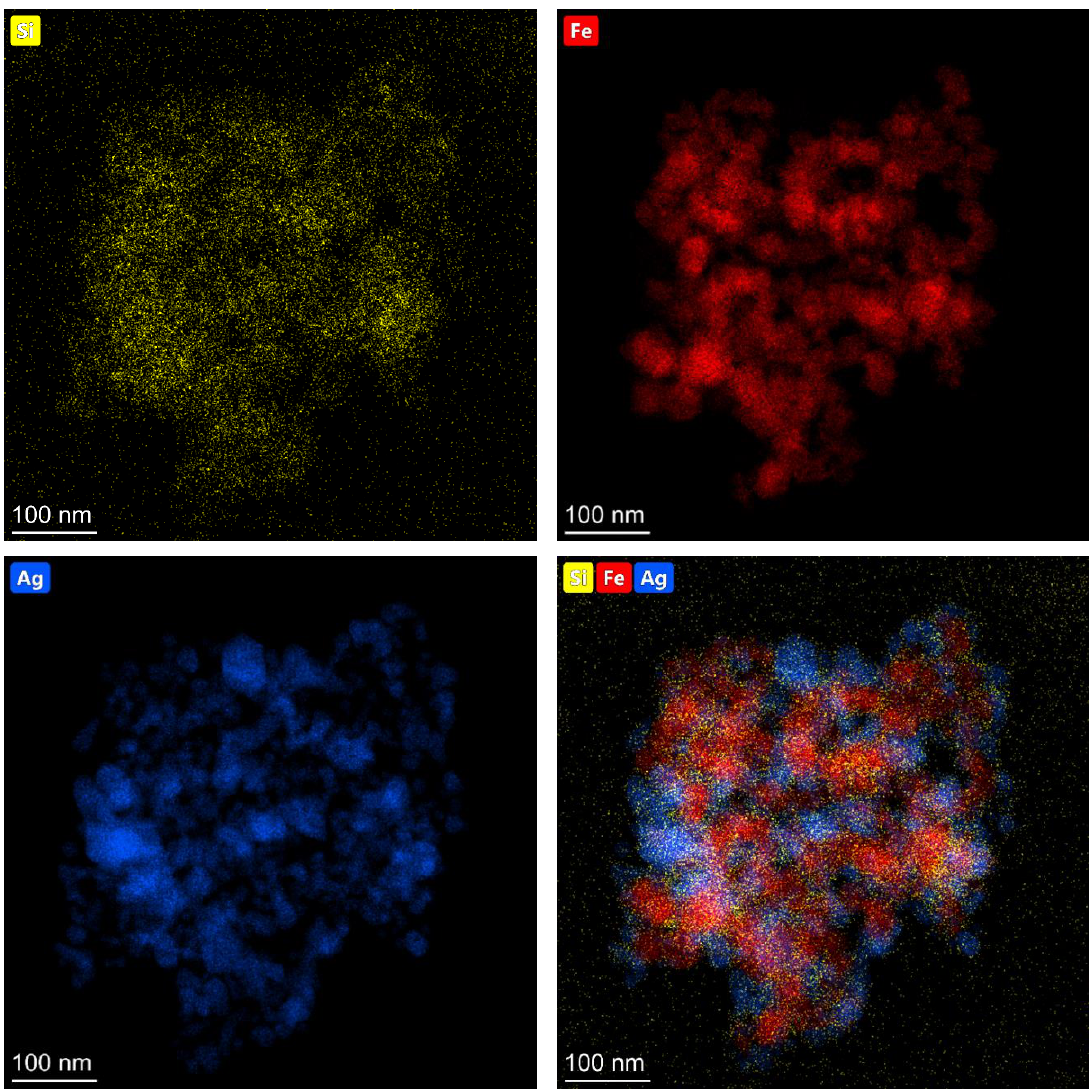
Figure 3. EDS maps showing the topographic distributions of silicon (yellow dots), iron (red dots), and silver (blue dots) in the resulting (Fe 3 O 4 @Ag)@SiO 2 nanocomposite.